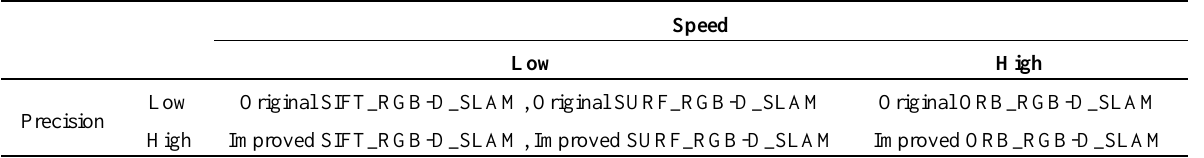
Table 8. Schematic diagram for a comprehensive analysis of the experimental